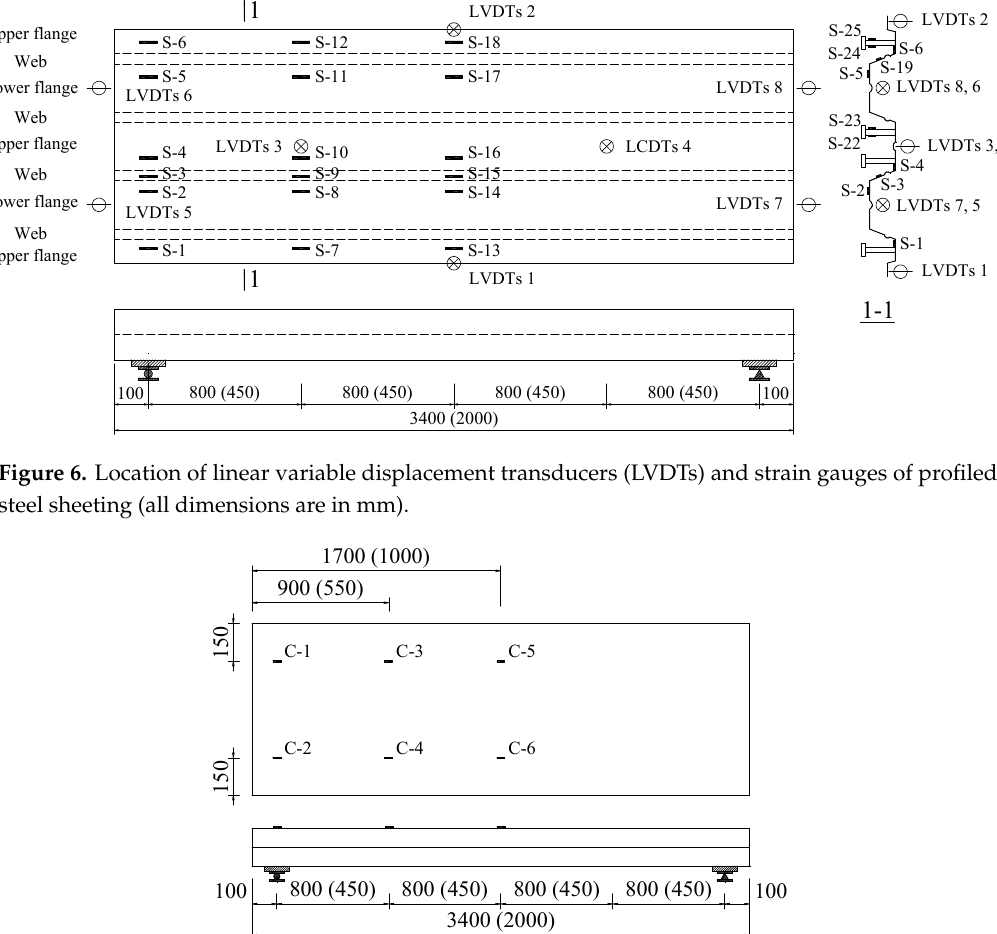
Table 5. Properties of SCRLC.